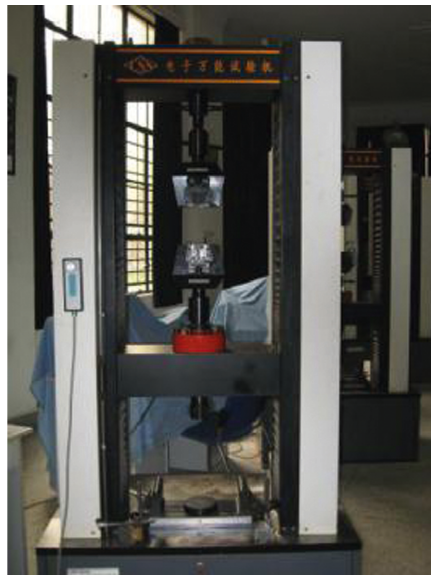
Figure 2: Electronic universal testing